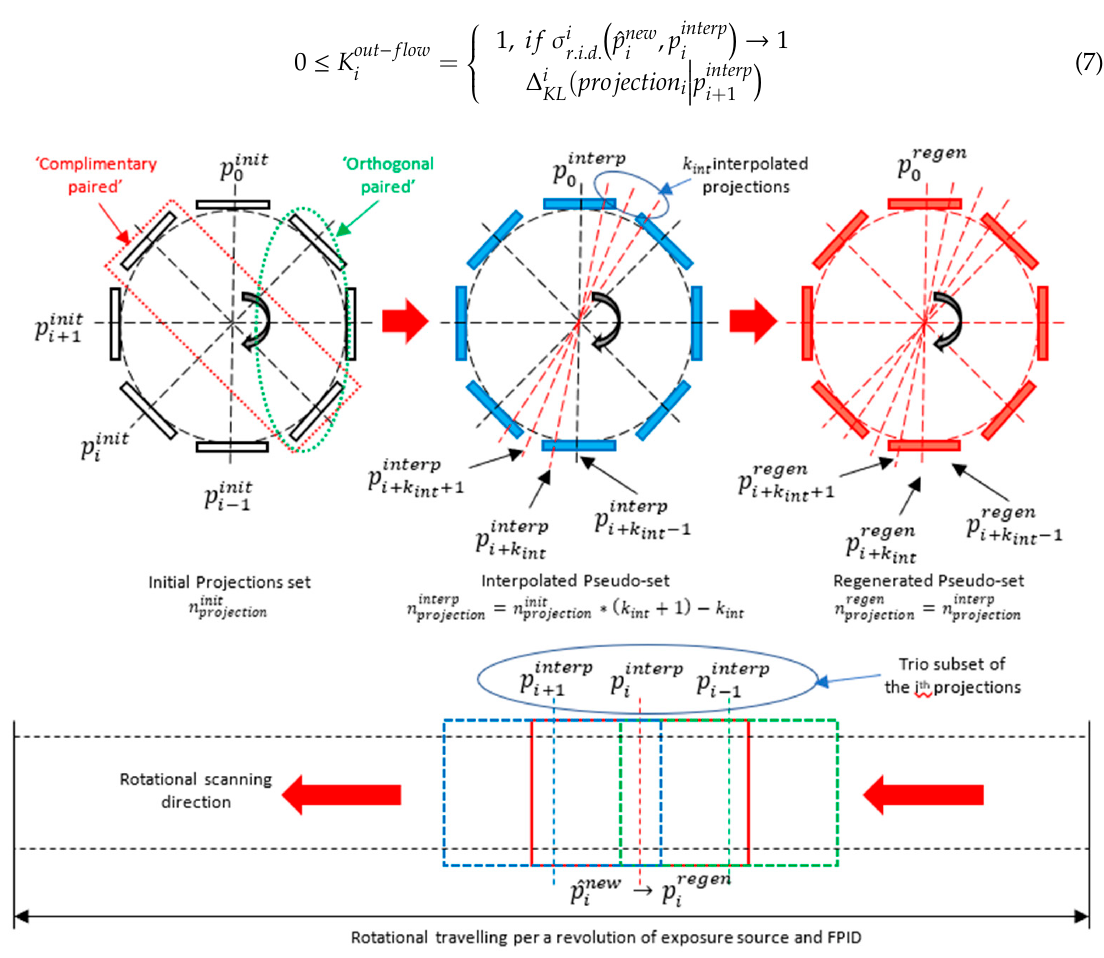
Figure 1. The illustrations of the projection set and the trio subset in selective anatomy analytic iteration reconstruction (SA2IR). Algorithm 1: “Densification enrichment process” or Pseudo-Set Interpolation